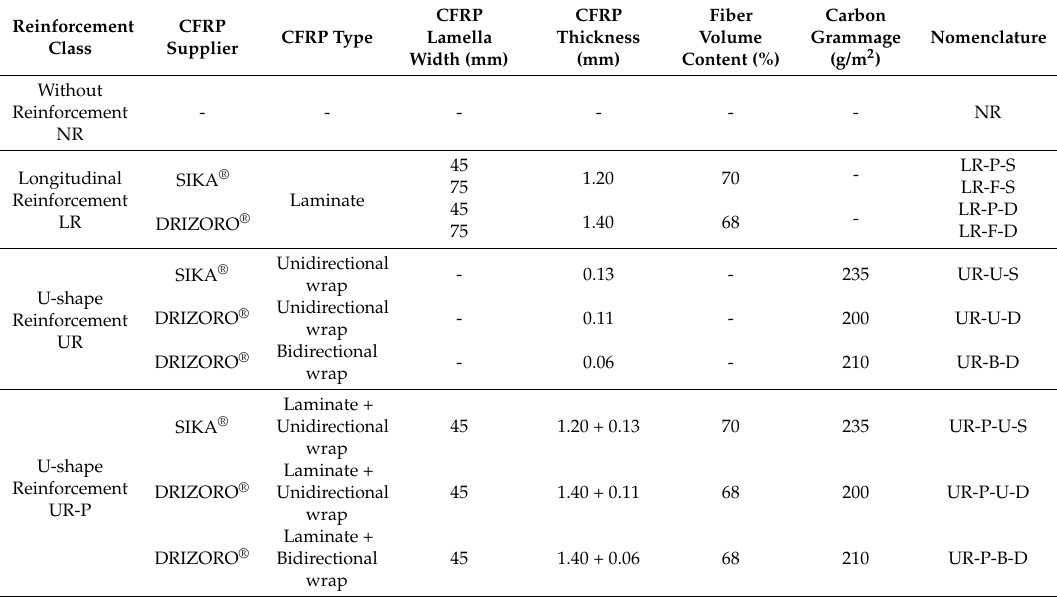
Table 1. Test matrix for reinforced and non-reinforced timber beams.